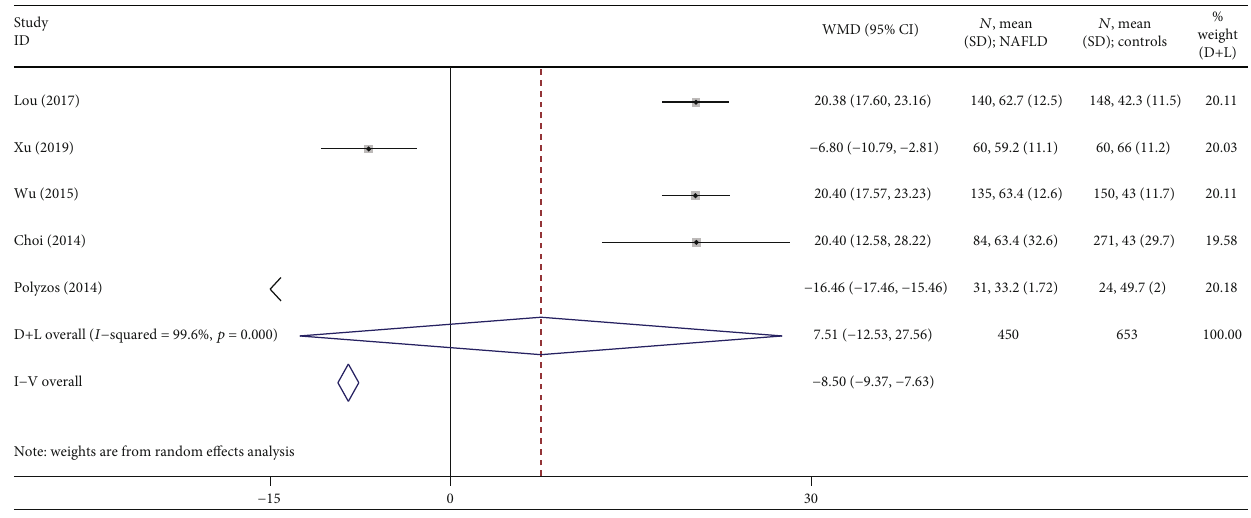
Figure 2: Forest plot analyzing the circulating irisin levels between the NAFLD group and healthy